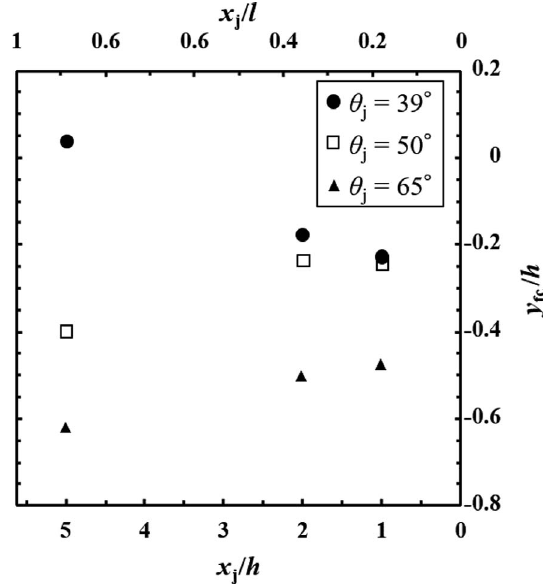
Figure 18. Spatial distributions of jet fl uctuation